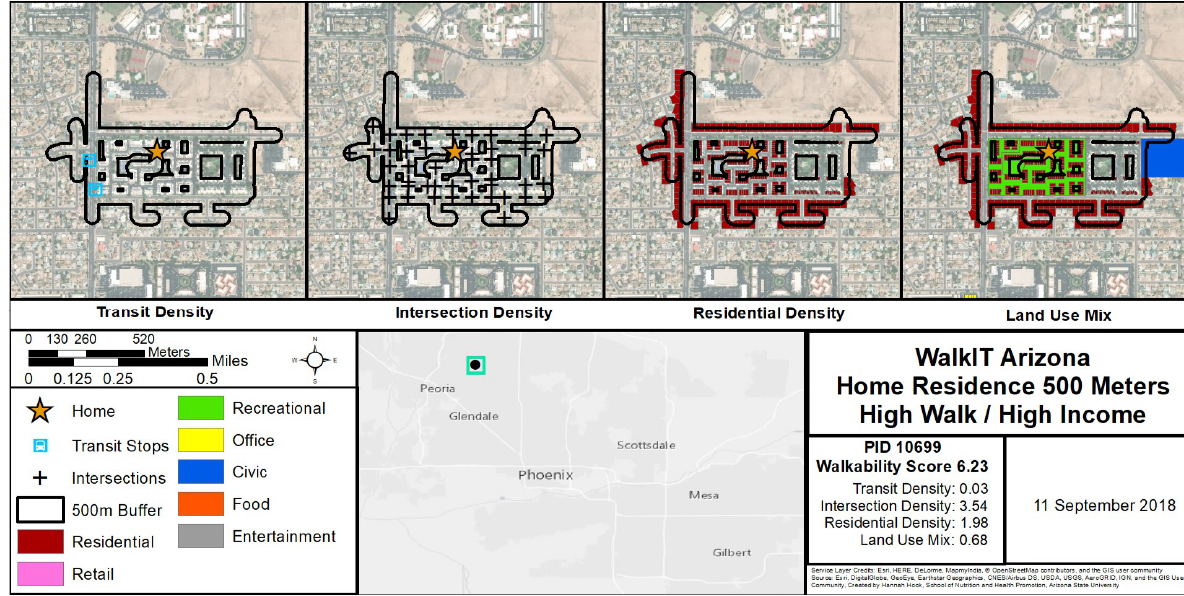
Figure 1. Example of individual-level buffers and macroscale walkability components and index values for a single participant’s neighborhood. Note: In the example in Figure 1, land-use mix shows residential, recreational, and civic uses. Other land uses such as office, food, entertainment, and retail were possible but not present in this